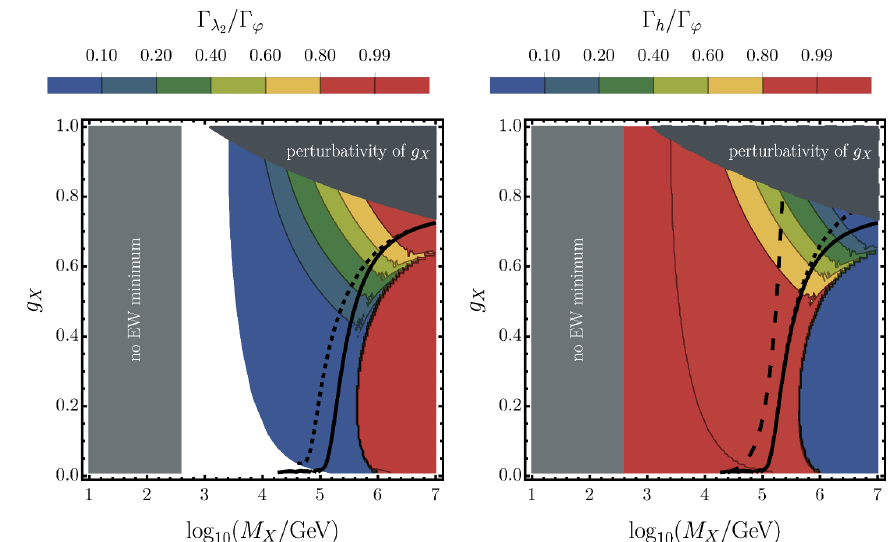
to Γ of eq. (4.17) computed using solely the S → HH Figure 21 . Left panel: the ratio of Γ λ ϕ 2 decay, Γ = 1 line (black, short-dashed), Γ = 1 line (black, solid). Right panel: the λ 2 /H ∗ ϕ /H ∗ ratio of Γ to Γ of eq. (4.17), Γ = 1 line computed using our methods (black, short-dashed), h ϕ h /H ∗ Γ = 1 line computed using the approach of ref. [82] (black, long-dashed) (see the main text h /H ∗ for